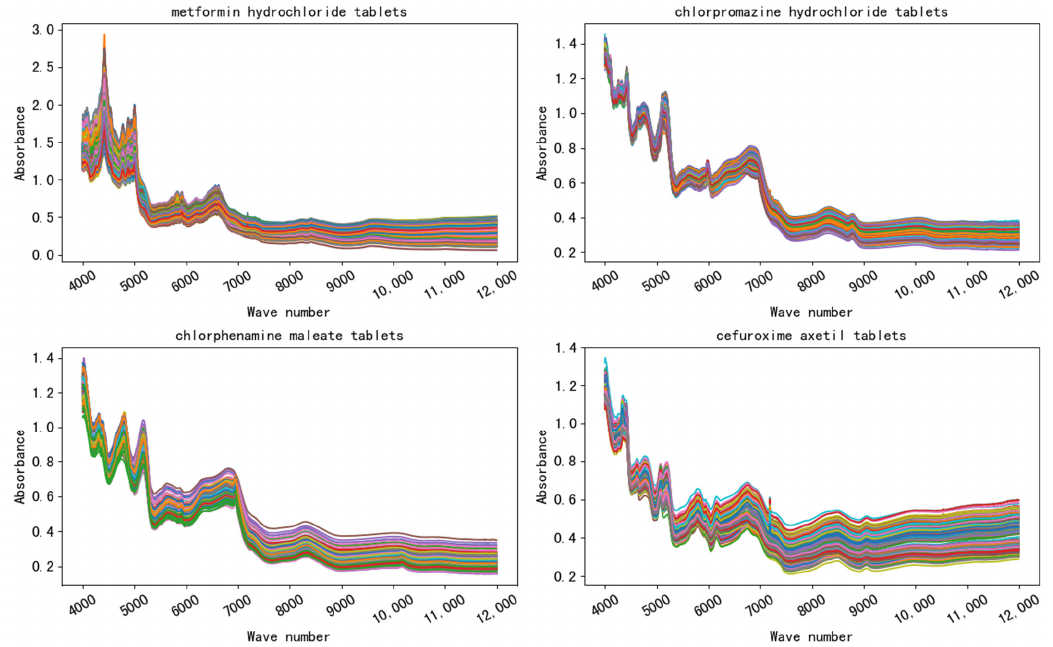
Figure 4. The spectra of four drugs. The same drug produced by different manufacturers according to the Pharmacopoeia of the People’s Republic of China (2015 version II) are very similar, and the important bands (peak and valley positions) mostly